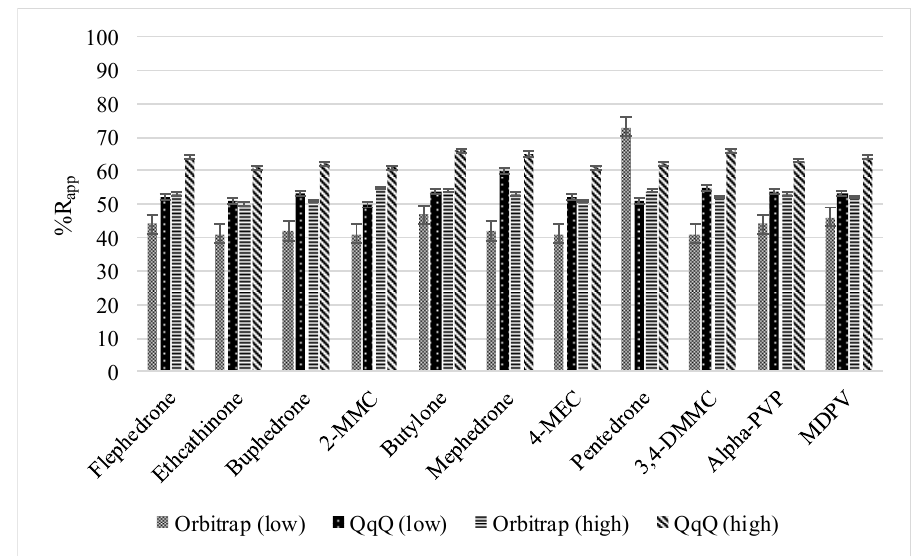
Figure 3. The %R app at low (1 ng g − 1 ) and high (40 ng g − 1 ) levels of concentrations for Orbitrap and QqQ in the analysis of synthetic cathinones in oral fluid (OF).